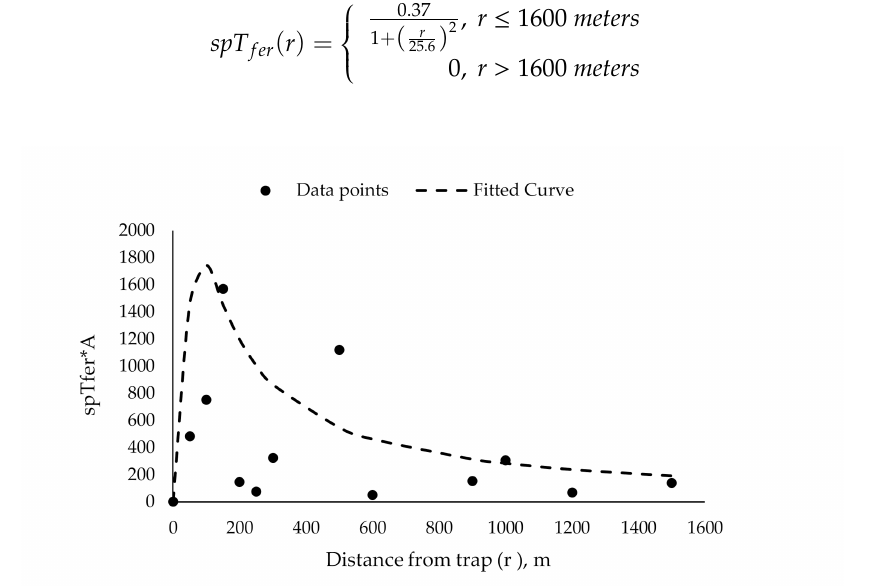
A) at various distances ×